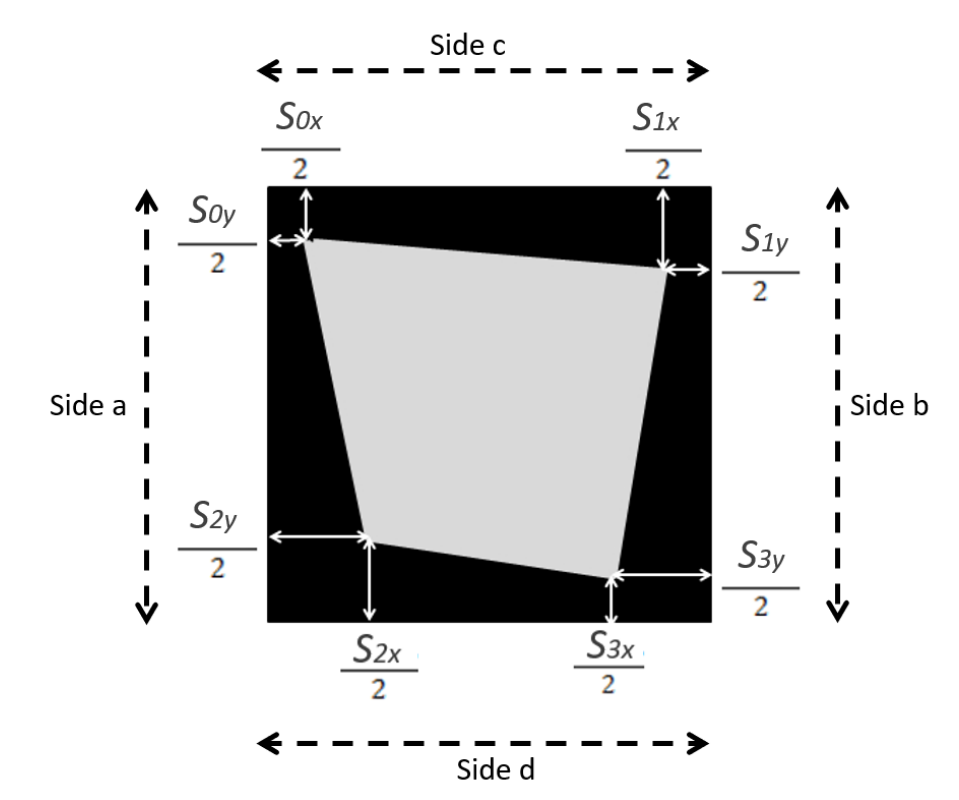
Figure 9. Trapezoid generated at bilinear